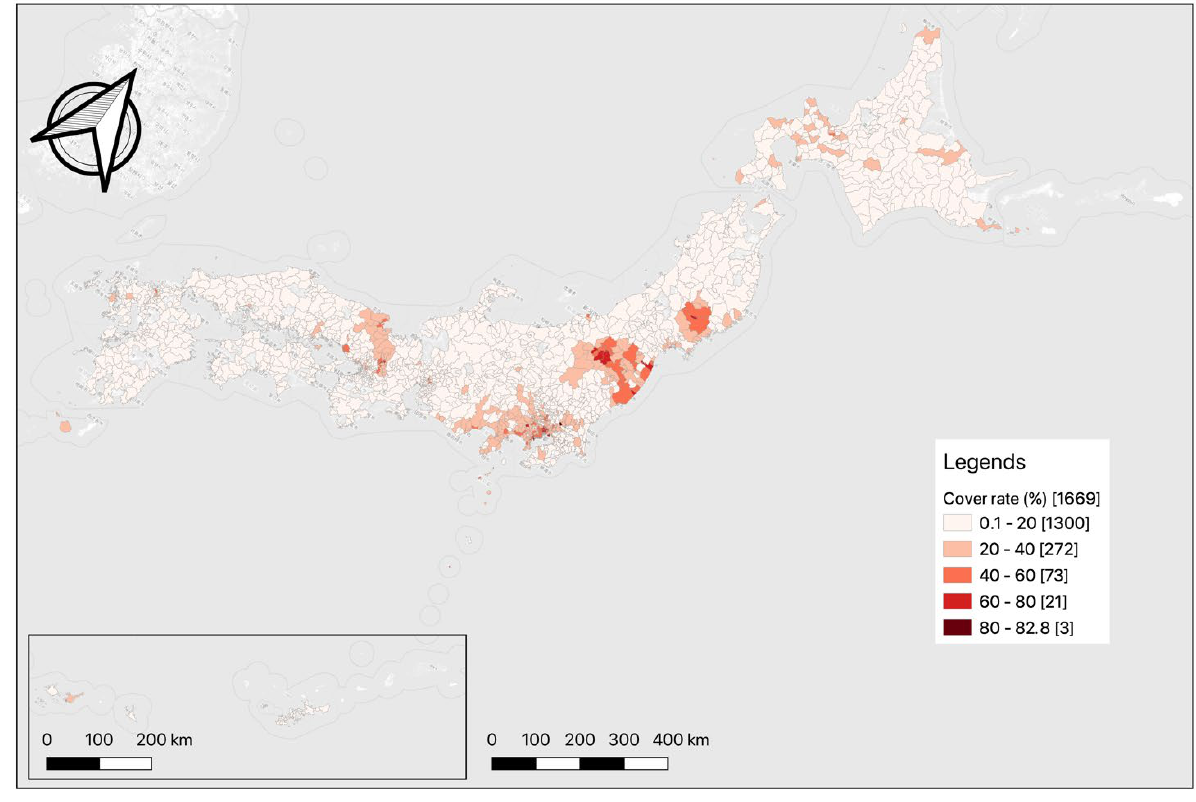
Figure 8. OpenStreetMap-Mapillary coverage by municipality (unit: %)